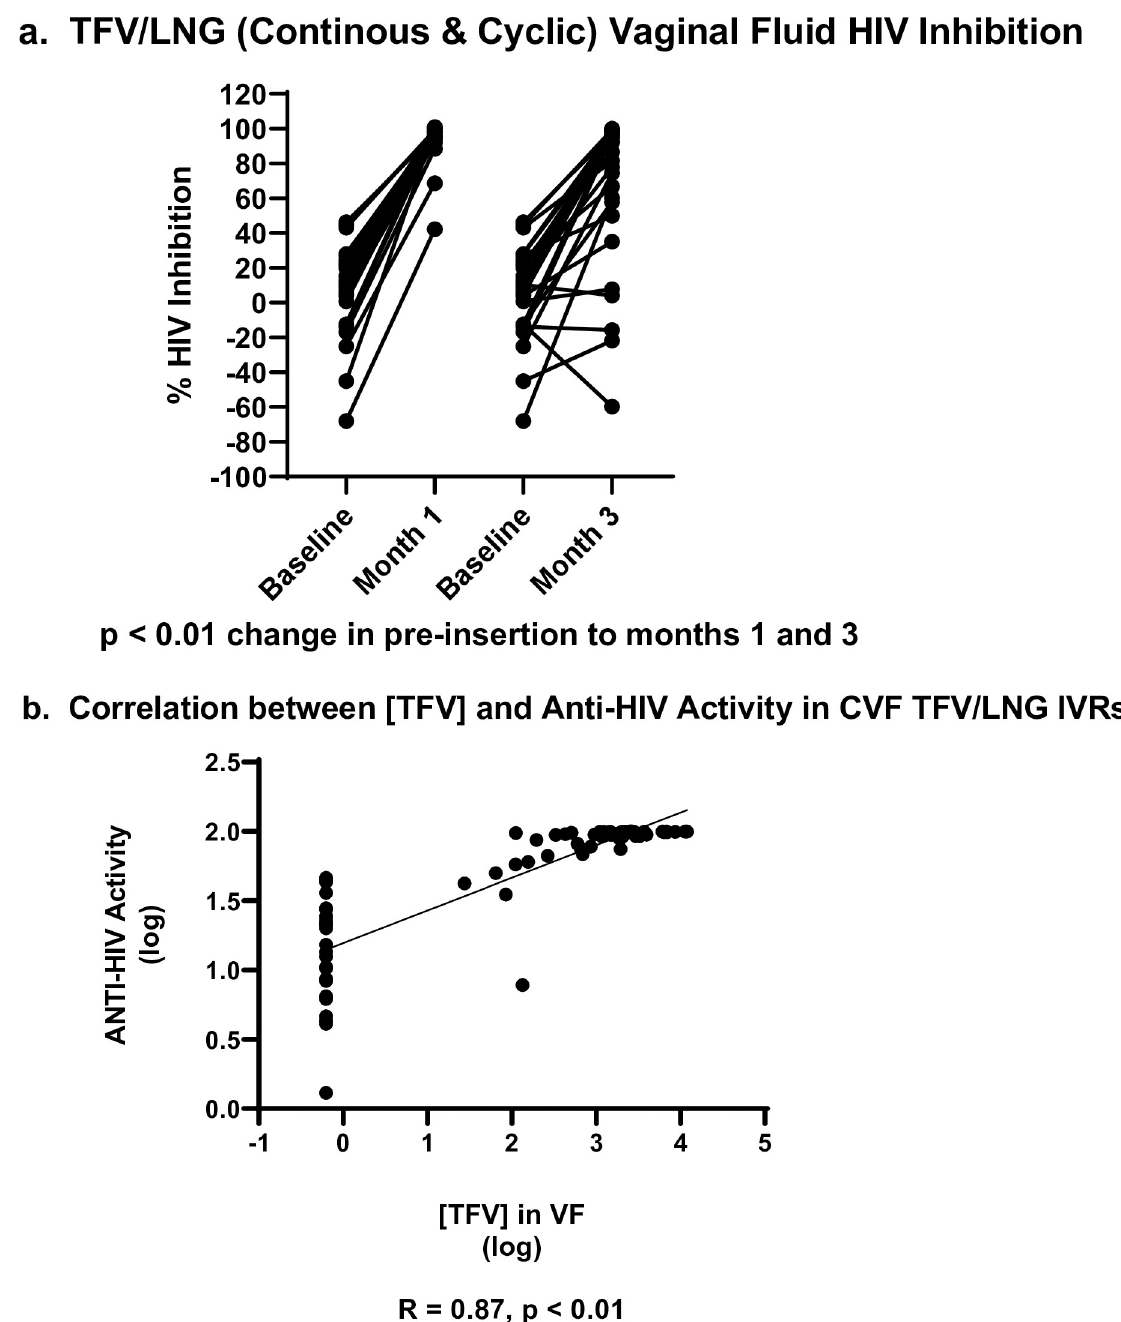
Fig 4. a. Inhibition of HIV growth in vitro by vaginal fluids of TFV/LNG IVR users (continuous and cyclic dosing regimens combined) at baseline and 1 and 3 months after use. b. Correlation between [TFV] and Anti-HIV activity in CVF TFV/LNG